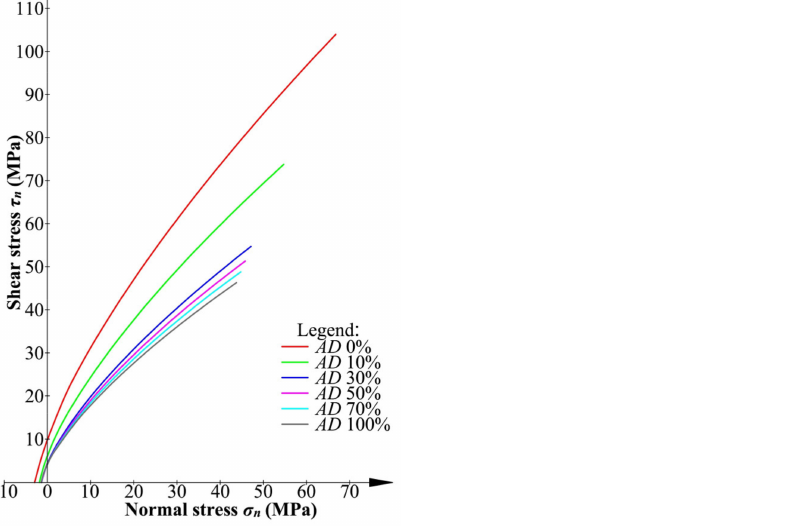
Figure 11. Relationship between shear and normal stresses for different participation of AD (Hoek– Brown failure criterion).